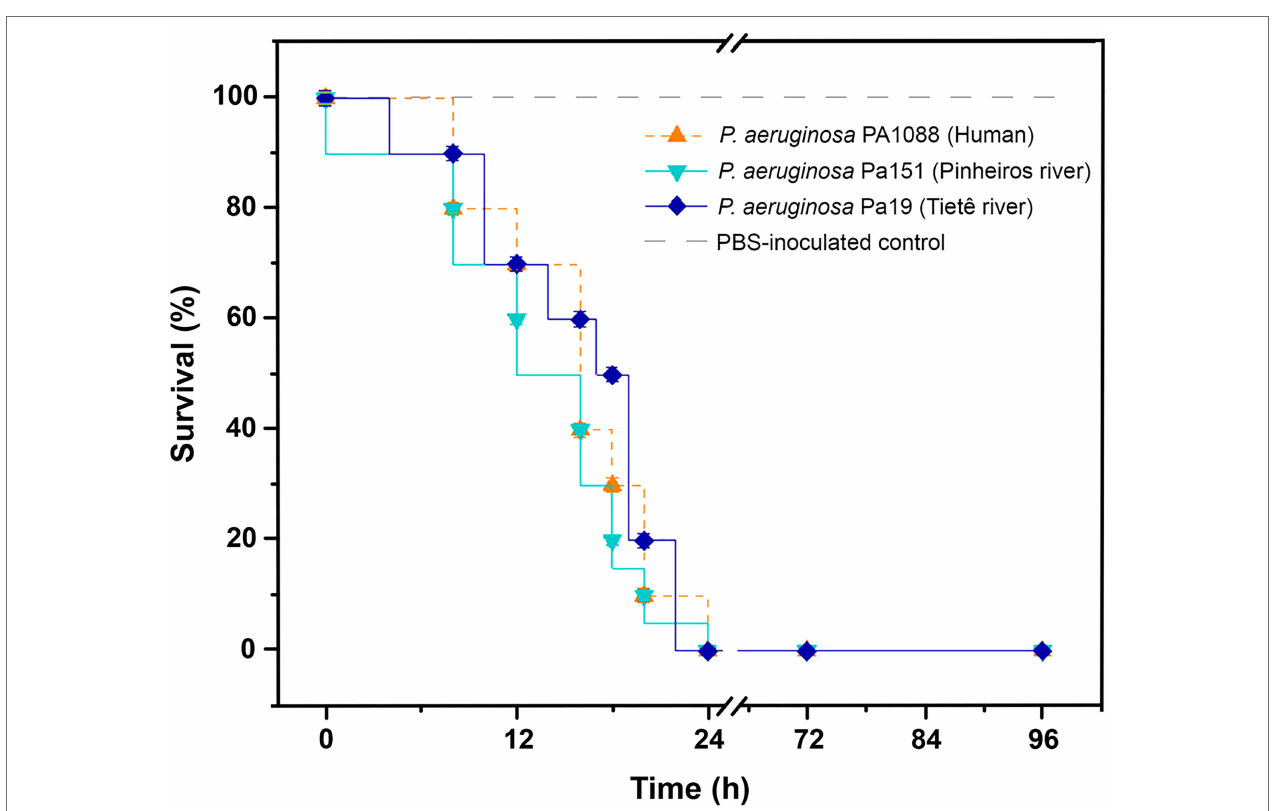
FIGURE 3 | Virulent behavior of SPM-1-producing P. aeruginosa isolates. Kaplan-Meier survival curves of Galleria mellonella infected with 10 4 CFU/larva of P. aeruginosa Pa19 strain (dark-blue line), P. aeruginosa Pa151 strain (blue line), and P. aeruginosa PA1088 (orange line). Environmental Pa19 and Pa151 strains, and the clinical PA1088 strain killed 100% of larvae at 24 h post-infection. PBS-inoculated control group (light-gray dashed line) presented 100% of survival. For each strain, groups containing 10 G. mellonella larvae in each replicate were evaluated in two biological and experimental independent